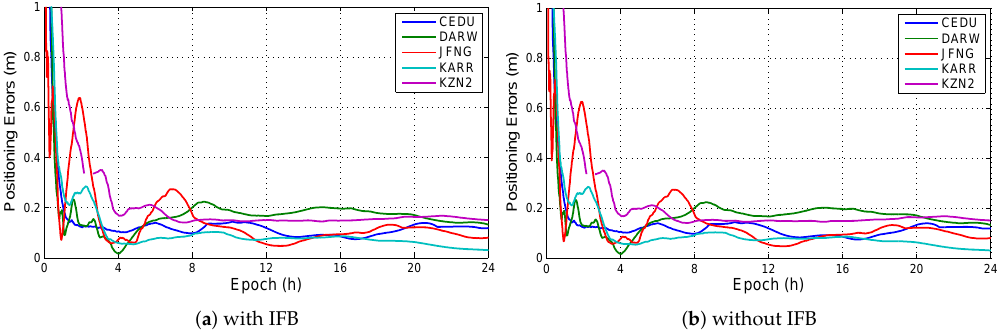
Figure 4. Positioning errors with or without IFB in UC3-BDS at different stations. ( a ) The positioning errors in UC3-BDS with IFB; ( b ) The positioning errors in UC3-BDS without